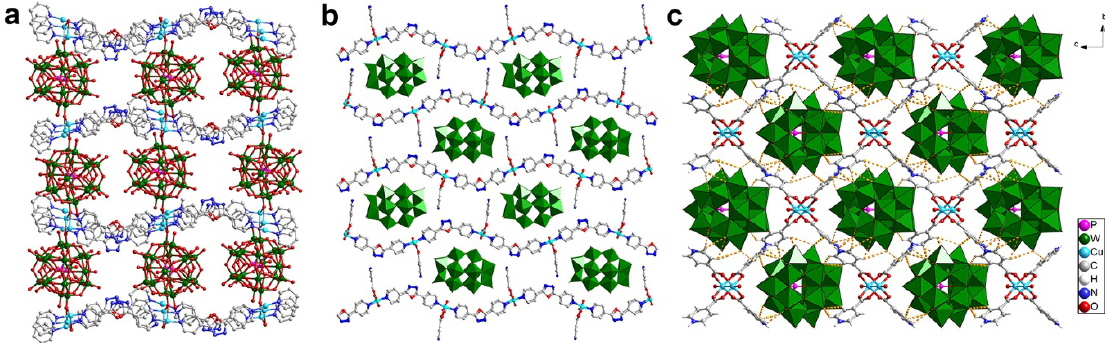
Figure 9. ( a ) Polyhedral and ball-and-stick representation for compound 17 ; ( b ) Space-filling and ball-and-stick representation for compound 18 ; ( c ) Ball-and-stick representation for compound 19